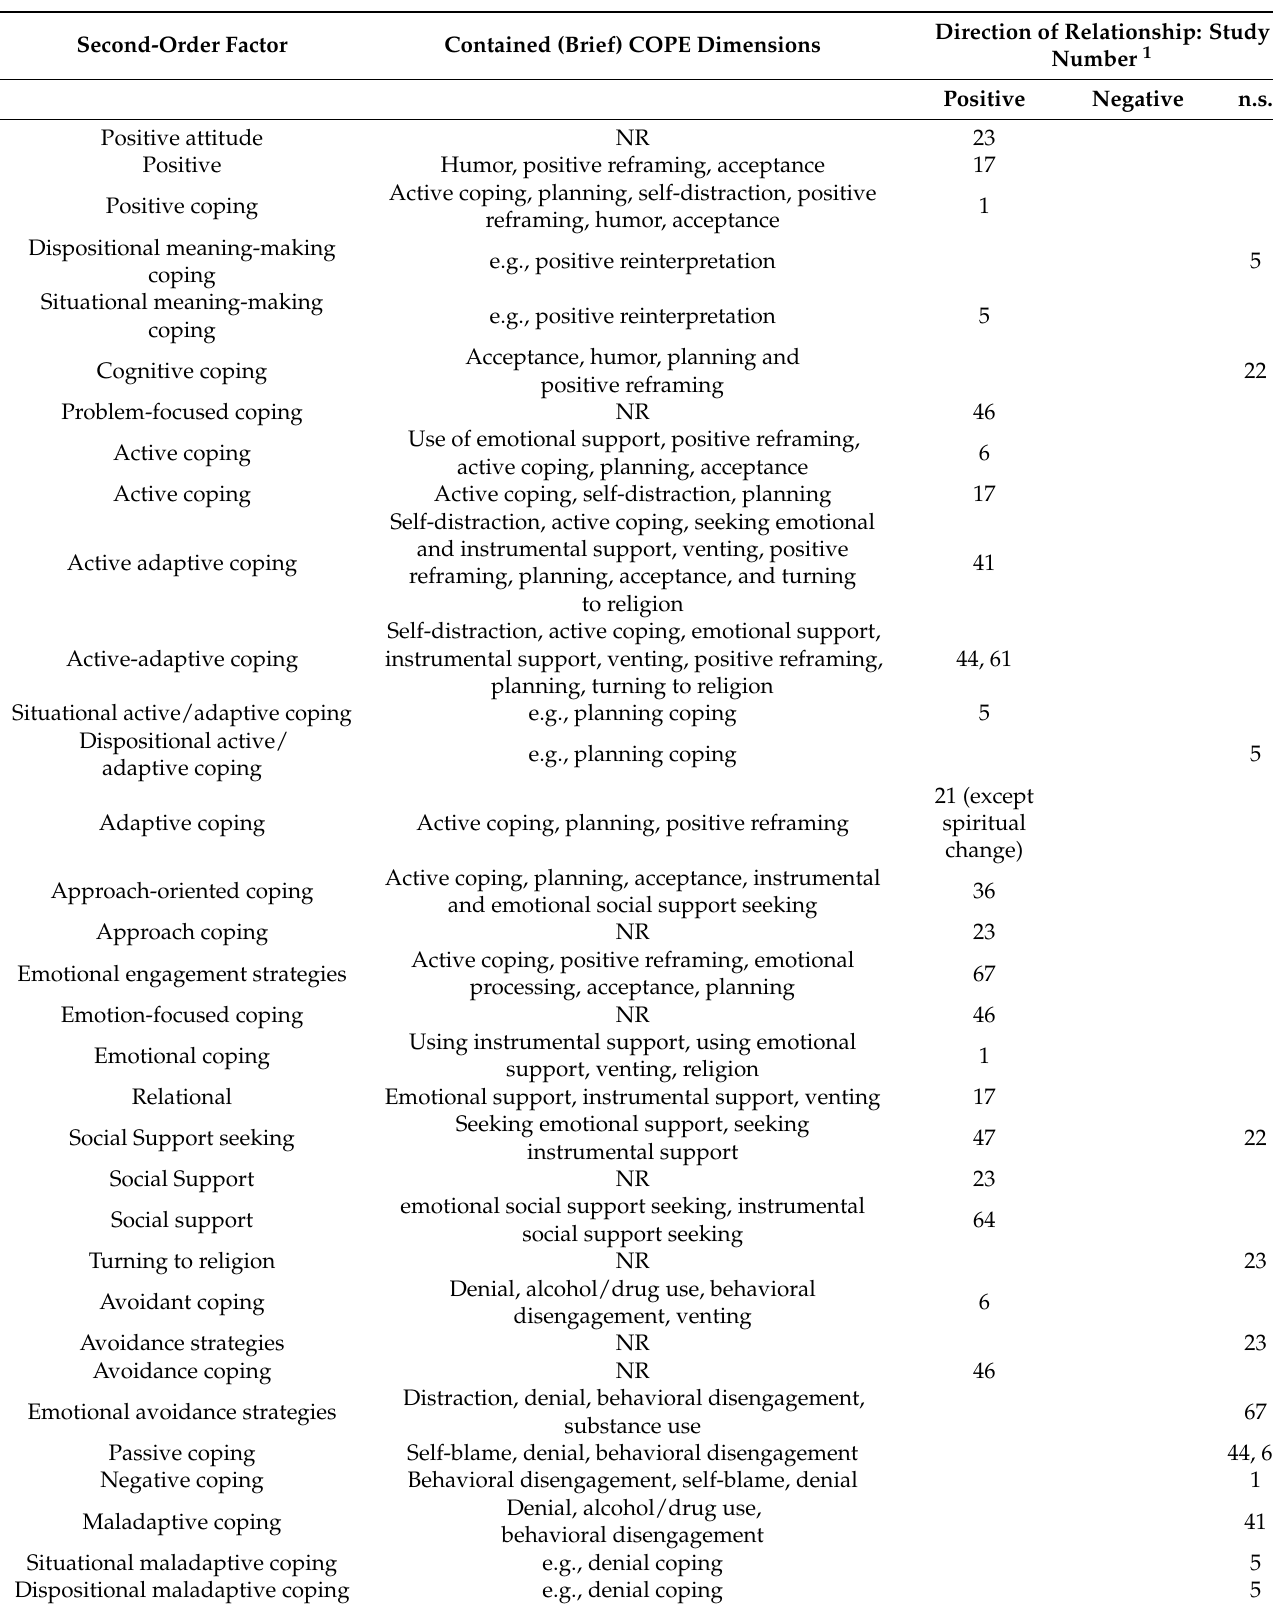
Table 6. Relationships of (Brief) COPE second-order factors with the PTGI total score. Contained (Brief) COPE Dimensions